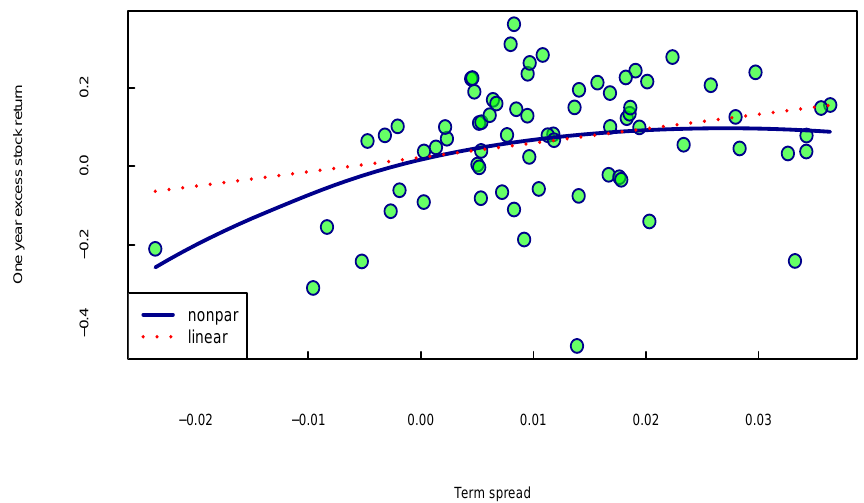
Figure 5. Risk-free benchmark. Relation between excess stock returns and term spread. Estimated nonparametric function ˆ m (dark blue line), linear model (dotted red line), observations (green balls). The sample period is